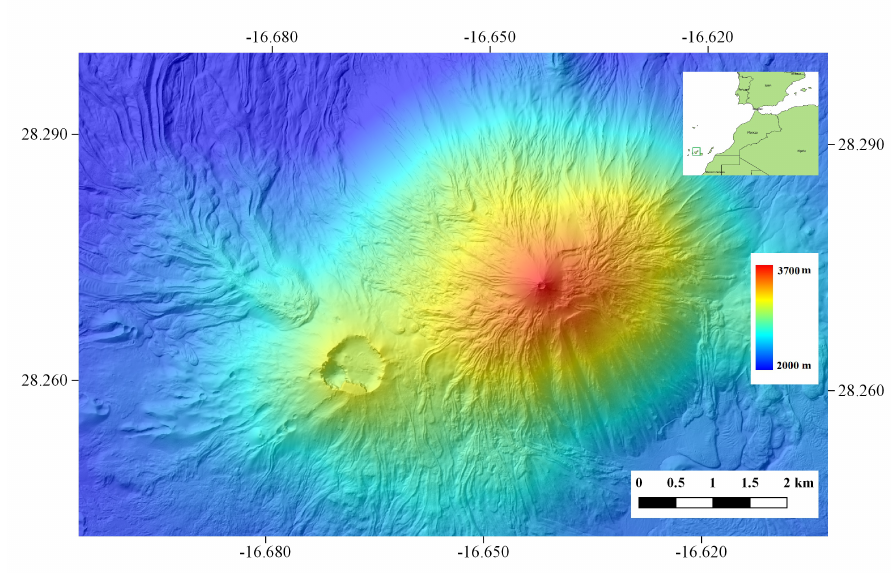
Figure 3. Color hypsometric 5 m LiDAR based DEM of Mount Teide in Tenerife, Canary Islands. To test the vertical accuracy of the PlanetScope DEM on the rugged terrain of the Himalaya and Karakoram mountain ranges, the Nanga Parbat (8126 m) massif in the western Himalaya was chosen, which is the ninth highest peak in the world. The region and the AOI is shown in Figure 4. The glaciers in the Nanga Parbat massif have shown relatively small retreat, which is in contrast to the glacial retreat in eastern Himalaya [46]. The Nanga Parbat peak offers steep vertical relief over various locations and is therefore, a suitable site for evaluation of the methodology especially in the context of the glaciated high mountain ranges. Other high peaks in the region could also be chosen for such study. The most cloud free days in this region are in late autumn (October/November) but at this time of the year the Sun elevation is considerably lower which leads to large shadows that cause problems in image matching. Therefore, the choice of area depends on the availability of cloud free data with fewer shadows. Furthermore, in comparison to peaks such as K2 (8611 m), Nanga Parbat offers stable terrain (non-glaciated) in close proximity, which is required for fine registration of the PlanetScope DEM with a reference DEM. For the Nanga Parbat test area, ALOS DEM was used as the reference DEM. In ALOS DEM, the horizontal coordinates are according to the Geodetic Reference System GRS80, while the elevations are referenced to the EGM96 geoid, which are converted to the ellipsoidal heights for computing the elevation